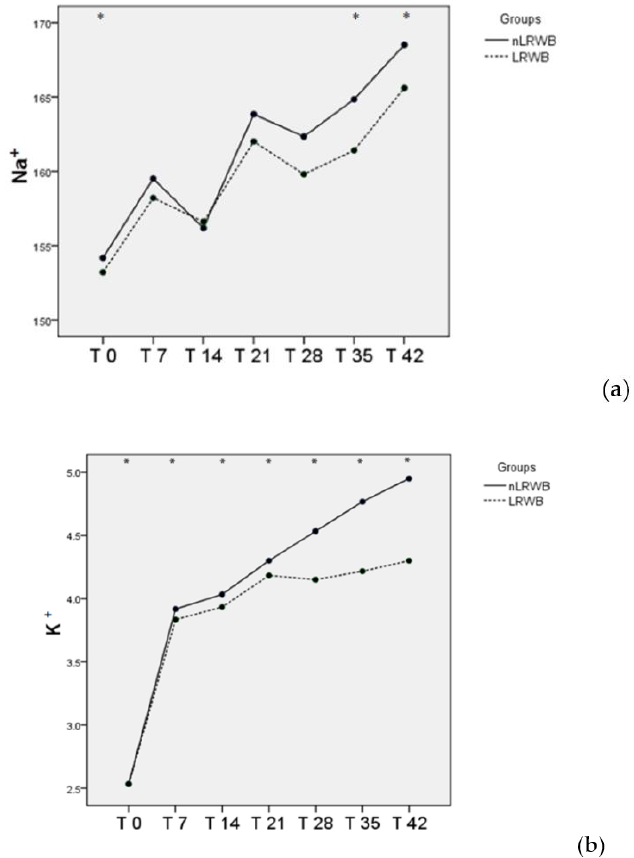
Figure 6. Differences in Na + (mean) ( a ) and K + (mean) ( b ) measured in nLRWB and LRWB units, during the storage period. The days of storage are presented in the x-axis. Na + and K + (mEq/L) is presented in the y-axis. Asterisks * p < 0.05.